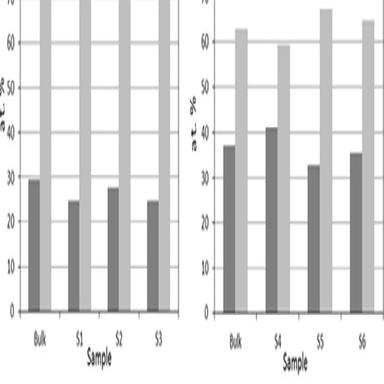
EDX analysis of the Bi2Te3 thin films as-deposited and annealed in vacuum and N2 atmospheres.